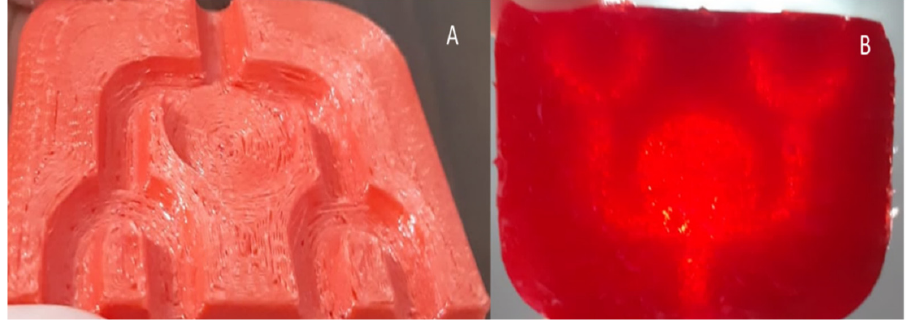
Figure 8. Lung ( A ) after being printed and ( B ) after being coated with resin.